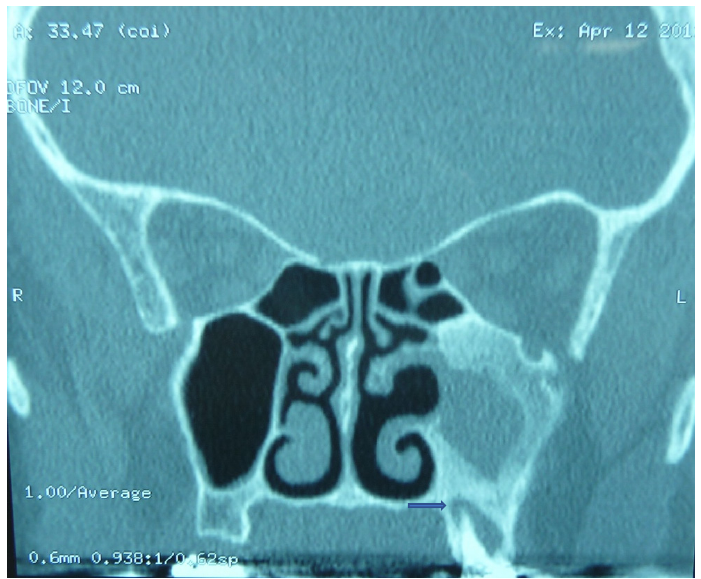
Figure 5. Computed tomography demonstrating left maxillary sinus opacification with surrounding hyperostosis secondary to a periapical abscess (horizontal arrow).